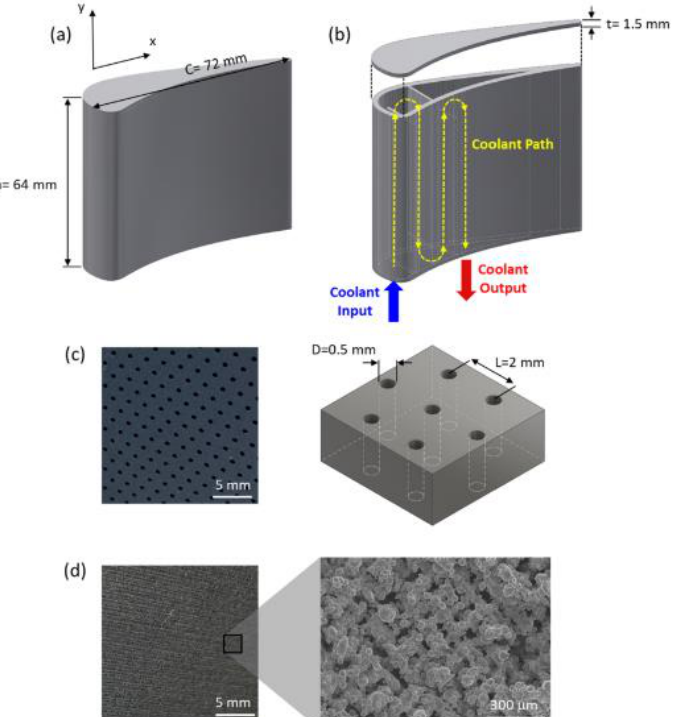
Figure 9. Illustration of transpiration cooling of a whole C3X blade. ( a ) dimensions of the exterior, ( b ) a typical internal cooling channel, ( c ) effusion cooling surface and ( d ) transpiration cooling surface. Reprinted/adapted with permission from Ref. [120]. 2020, Elsevier